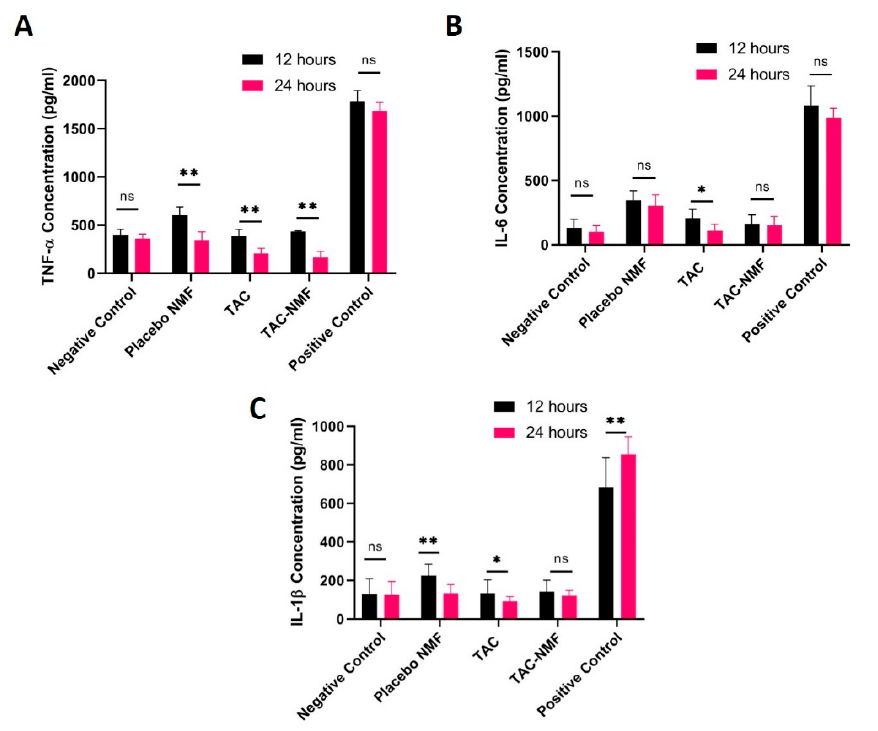
Figure 13. In-vitro release of TNF- α ( A ), IL-6 ( B ) and IL-1 β ( C ) and from RAW 264.7 cells following 12 and 24 h exposure of tacrolimus (TAC), placebo NMF and TAC-NMF using ELISA. Results are expressed as mean of three independent experiments, n = 3 ± SD. (* p ≤ 0.05 as compared to 12 h ** p ≤ 0.01 as compared to 12 h, ns = not significant difference between groups) .